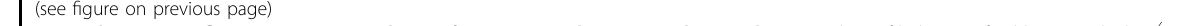
Fig. 3 The NLRP3 in fl ammasome is a mediator of SD-associated anxiety and microgliosis. Analysis of behavior of wild-type and Nlrp3 -/- mice tested in the Dark-Light Box task. Mice were then subjected to 6 h SD for 6 days, then tested in the elevated plus maze task. ( A ) Timeline of behavioral studies. ( B – D ) Time spent in the Light Zone ( B ), Entries into the Light Zone ( C ), and Total Distance traveled in the dark-light box task ( D ). ( E – G ) Time spent in the open arms ( E ), Entries into the open arms ( F ), and total distance traveled in the elevated plus maze task ( G ). N = 19 – 22 mice/group for dark-light box, 10 – 14 mice/group for Elevated Plus Maze. ( H ) mRNA expression of the in fl ammation-related genes IL1b, Nlrp3 , and Hmgb1 in the hippocampus. ( I ) mRNA expression of the I κ B genes Nfkbia , Nfkbib , and Nfkbie in the hippocampus. ( J ) mRNA expression of the circadian clock genes Bmal1 and Clock in the hippocampus. N = 3 – 9 mice/group. ( K ) Representative hippocampal microglia. Red: Iba1. Green: Soma. Yellow: Branches. Scale bar: 15 μ m. ( L – N ) Numbers ( L ), Total branch length per cell ( M ), and total branch endpoints of hippocampal microglia ( N ). N = 4 – 6 mice/group, >4 hippocampal sections studied per animal. For anatomical studies, >25 cells studied per section. * p < 0.05 , ** p < 0.01 , ***p < 0.001, ****p < 0.0001 by Two-Way ANOVA with Tukey ’ s